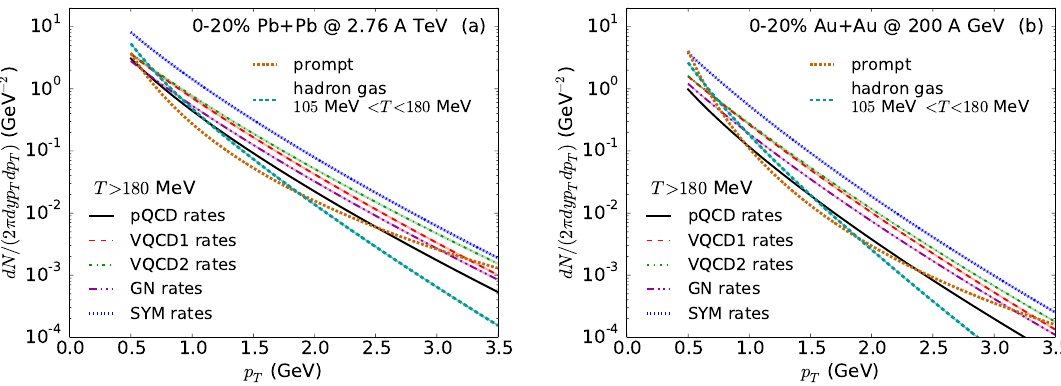
Figure 4 . (Color online) Comparisons of thermal QGP photon spectra using di(cid:11)erent sets of photon emission rates from T > 180 MeV regions in 0{20% Pb+Pb collisions at 2.76 A TeV (a) and 0{20% Au+Au collisions at 200 GeV (b). Spectra of hadronic photons and prompt photons are also